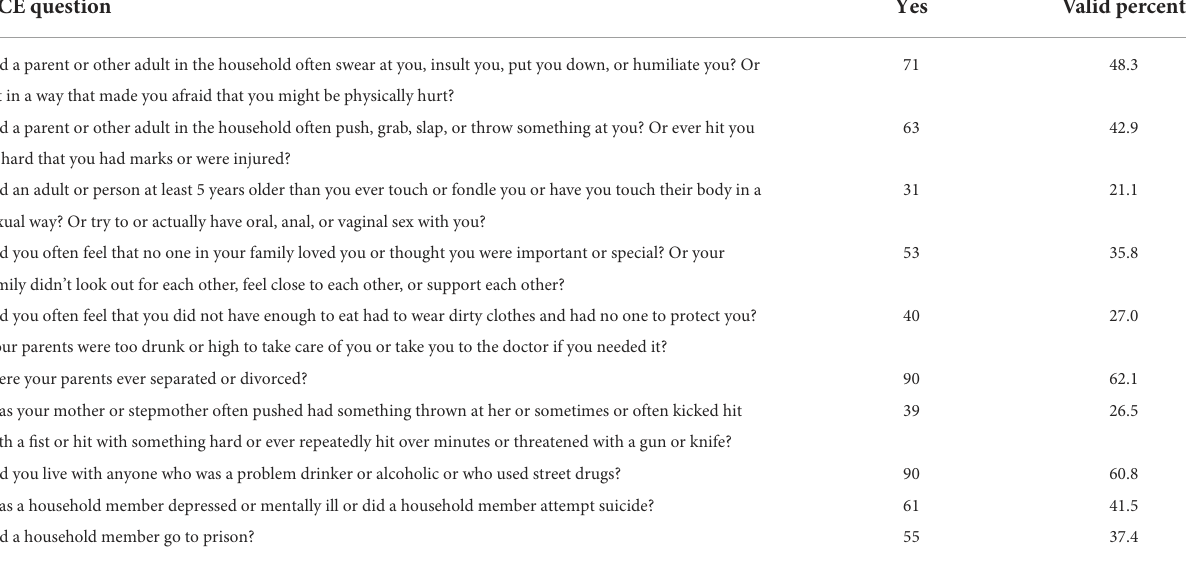
TABLE 2 Sample exposure to adverse childhood experiences (ACEs), n =